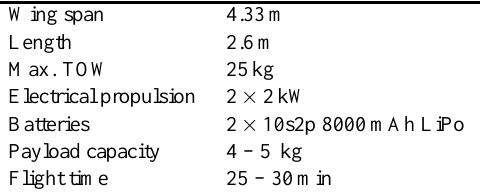
Table 1: Technical data of the